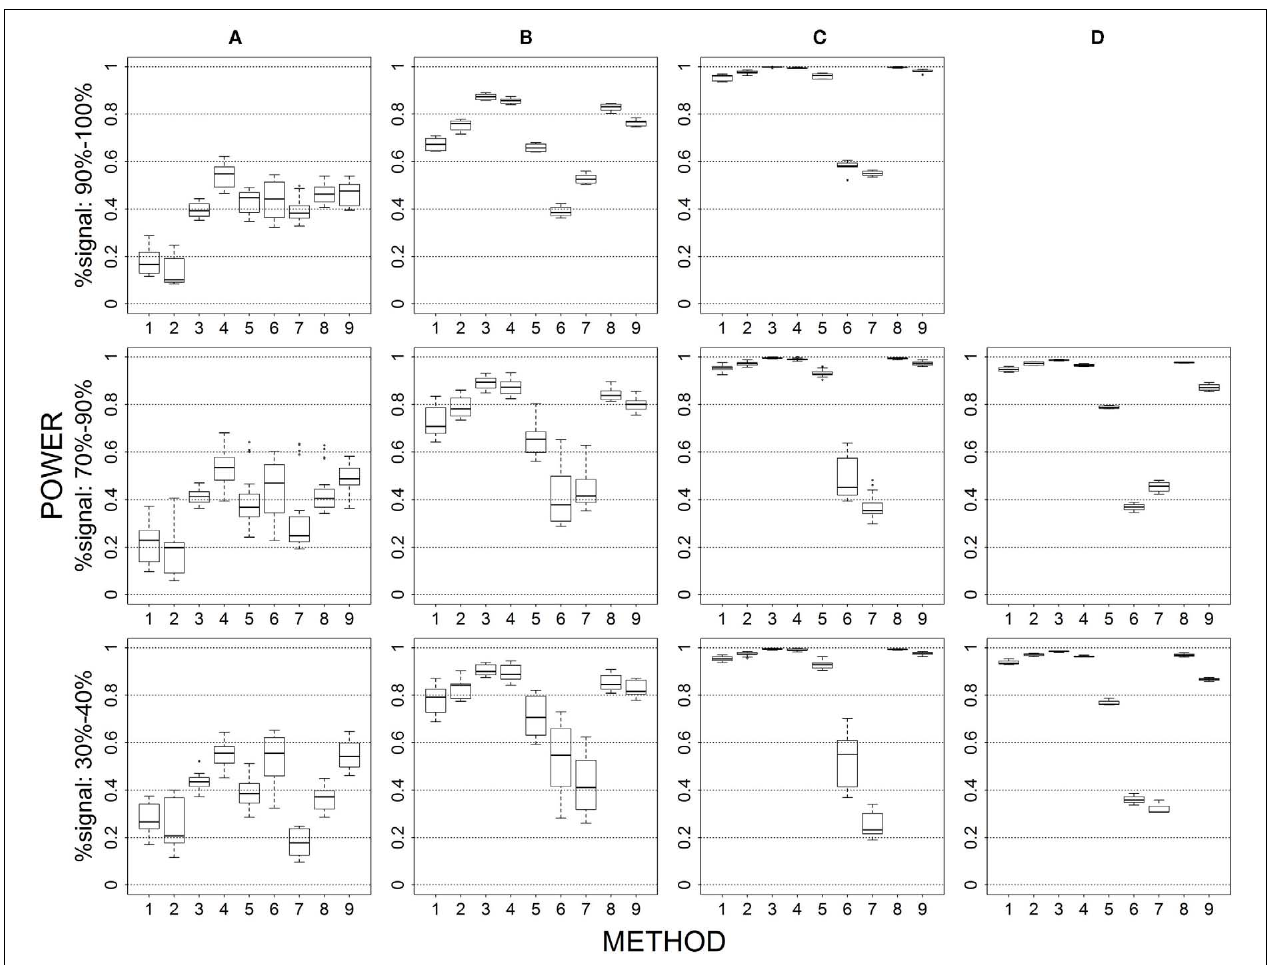
power results for marker-combinations belonging to each average functional allele frequency [ (A) is 0.02–0.06, (B) is 0.06–0.10, (C) is 0.10–0.14, (D) is